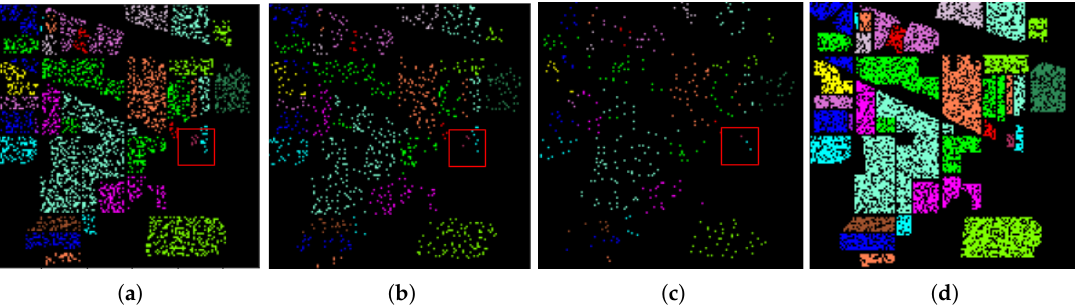
Figure 5. ( a – c ) The train split with 30%, 10%, and 4% training size on Indian Pine (IP) dataset ( d ) the test